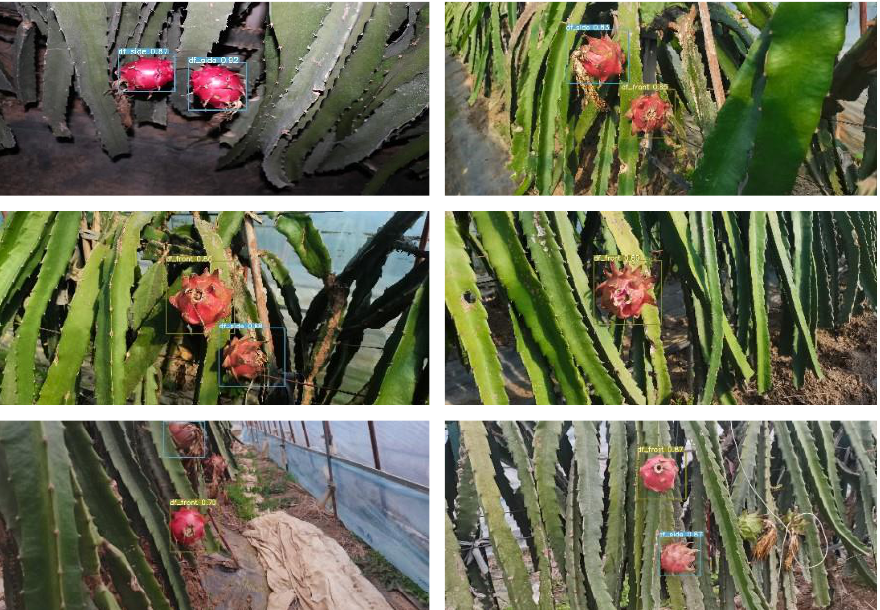
Figure 8. The visualization results of detecting dragon fruit under different light conditions by using the RDE-YOLOv7 model.